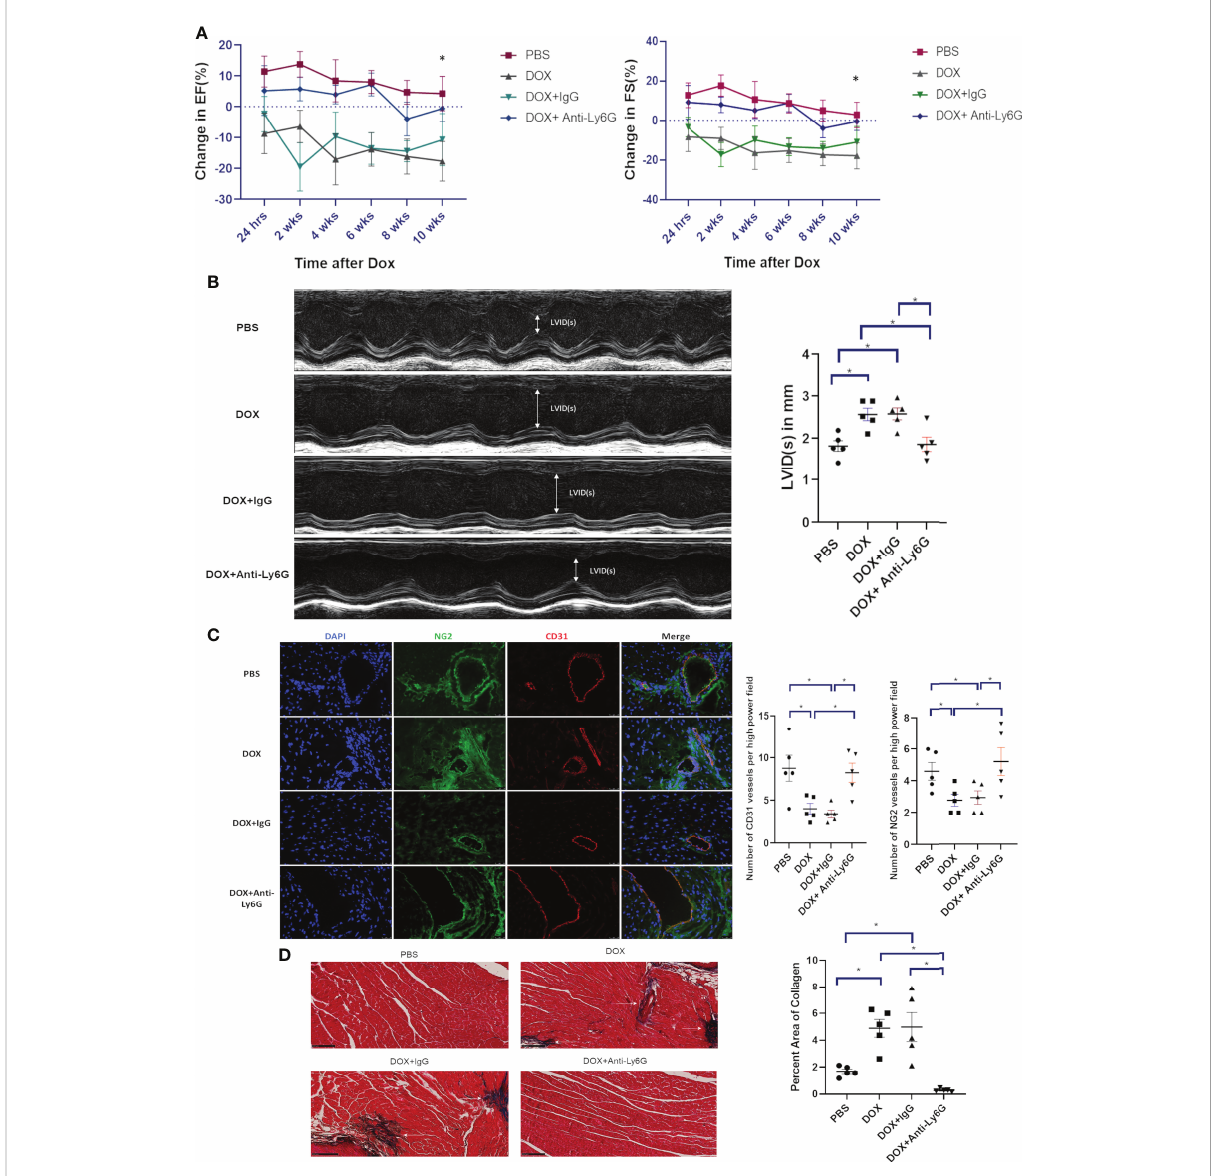
FIGURE 3 Effect of neutrophil depletion on heart function and vascular morphology 10 weeks after therapy. (A) In mice treated with control phosphate- buffered saline(PBS), doxorubicin(DOX), DOX plus control IgG, or DOX plus anti-Ly6G, ejection fraction(EF) and fractional shortening(FS) were quanti fi ed by echocardiography and followed for 10 weeks after therapy; (B) Left ventricular internal dimension in systole (LVID(s)) was also quanti fi ed 10 weeks after therapy; (C) Representative images and numbers of NG2 + and CD31 + vessels in the hearts of mice treated with control phosphate-buffered saline (PBS), doxorubicin (DOX), DOX plus control IgG, or DOX plus anti-Ly6G 10 weeks after therapy; (D) Collagen deposition in the hearts was determined using Masson trichrome staining 10 weeks after therapy completion. Data are presented as mean ± SEM, n = 5 each, * p < 0.05, one-way ANOVA analysis with Tukey comparison was used to compare the